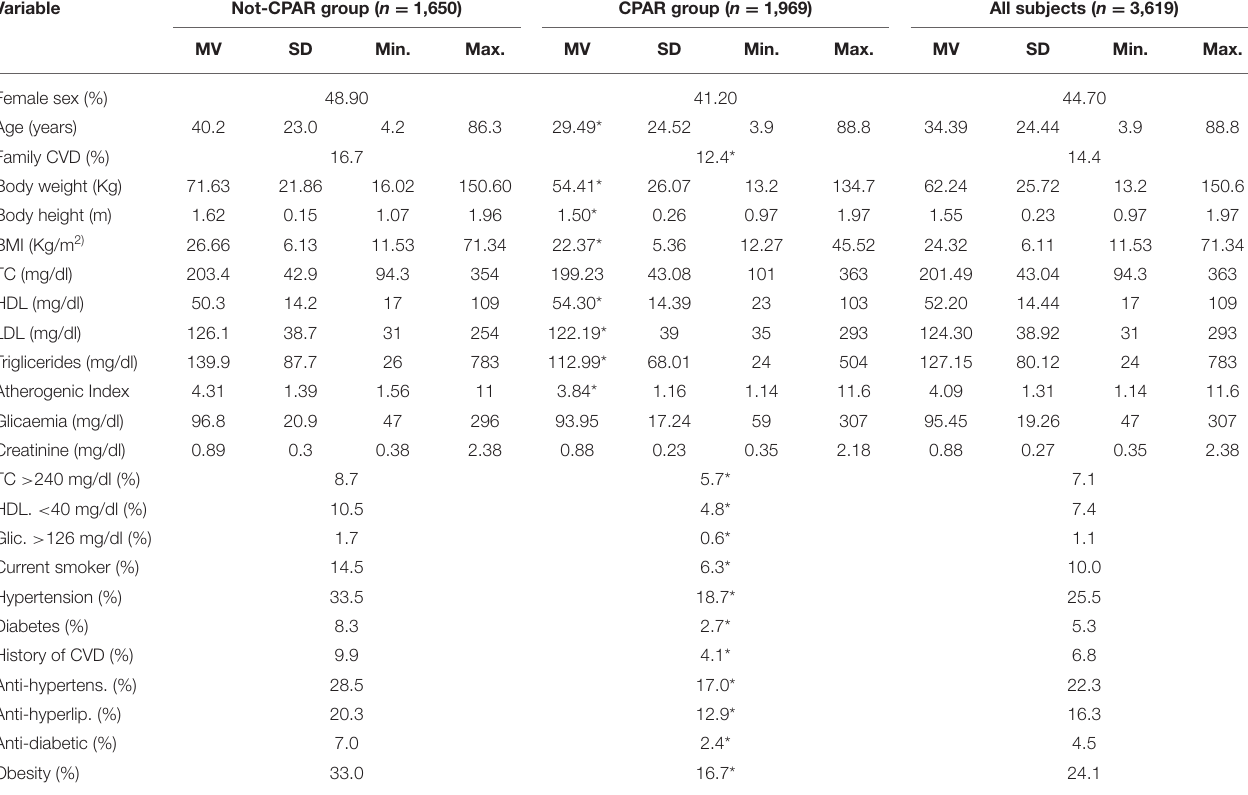
TABLE 1 | Characteristics of the subjects according to compliance with physical activity recommendations (CPARs). Variable